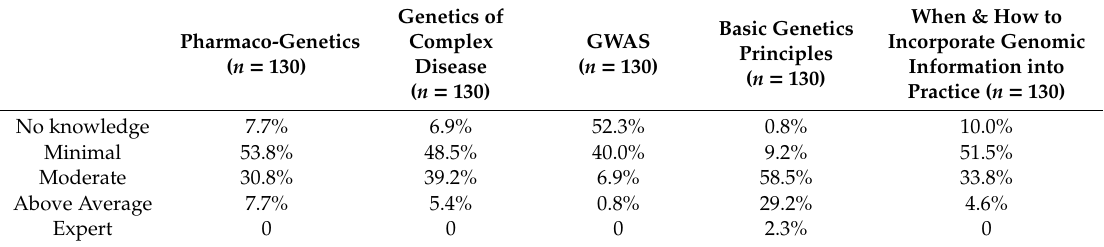
Table 4. Perceived knowledge at pre-testing phase among respondents who completed the pre-testing and post-testing survey ( n =